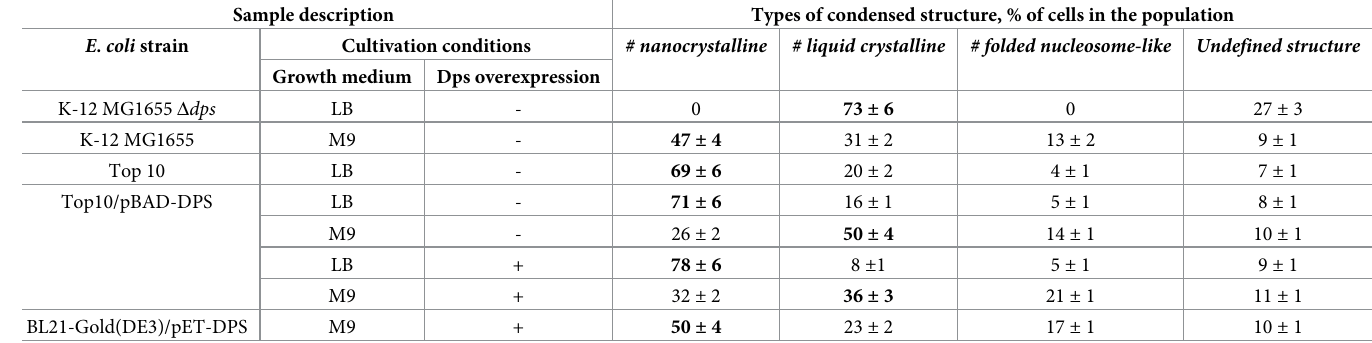
Table 2. Variety of condensed DNA-Dps types in studied E . coli dormant